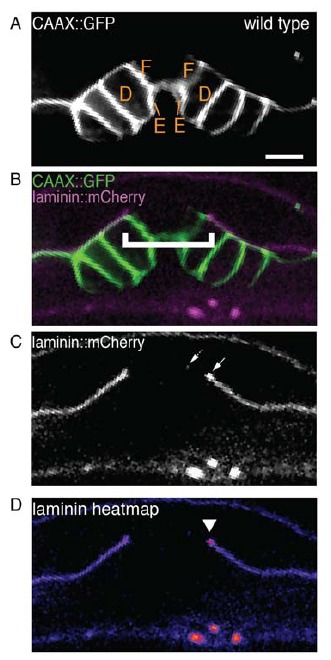
(A) and (B) Are the image panels from the manuscript submitted on August 23, 2016.(C) The single-channel image of laminin::mCherry showing the BM gap edge (solid arrow) and a puncta of laminin signal to the left (dotted arrow) that is discontinuous from the rest of the BM. D) A heatmap of the laminin::mCherry fluorescence showing an increase in laminin at the previously identified BM gap edge (arrowhead).